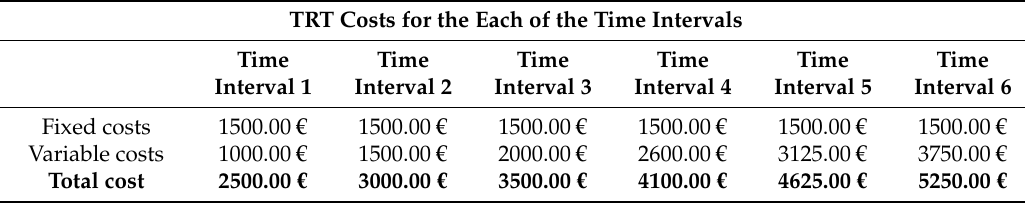
Table 13. Estimation of the cost of the TRTs for the time intervals considered in this work. TRT Costs for the Each of the Time